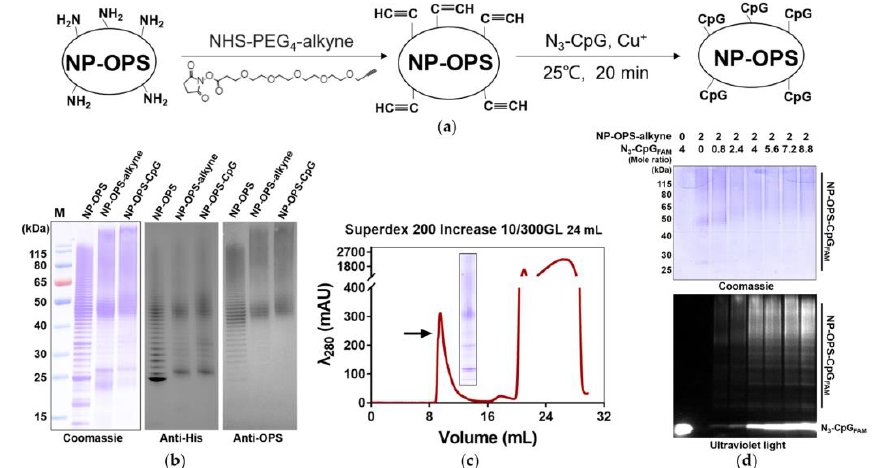
Figure 1. Preparation of the NP-OPS-CpG conjugate vaccine. ( a ) Schematic diagram of the NP-OPS-CpG preparation. ( b ) Purified NP-OPS, NP-OPS-alkyne, and NP-OPS-CpG were detected by Coomassie blue staining and Western blotting with antibodies against the 6 × His tag and S. flexneri OPS. ( c ) Analysis of purified NP-OPS-CpG by size-exclusion chromatography (Superdex 200, 24 mL). The peak position of NP-OPS-CpG is indicated by an arrow, and detected by Coomassie blue staining. ( d ) NP-OPS-CpG FAM obtained with different NP-OPS-alkyne and N 3 -CpG FAM ratios was separated by SDS-PAGE, analyzed by Coomassie blue staining, and observed under ultraviolet light.